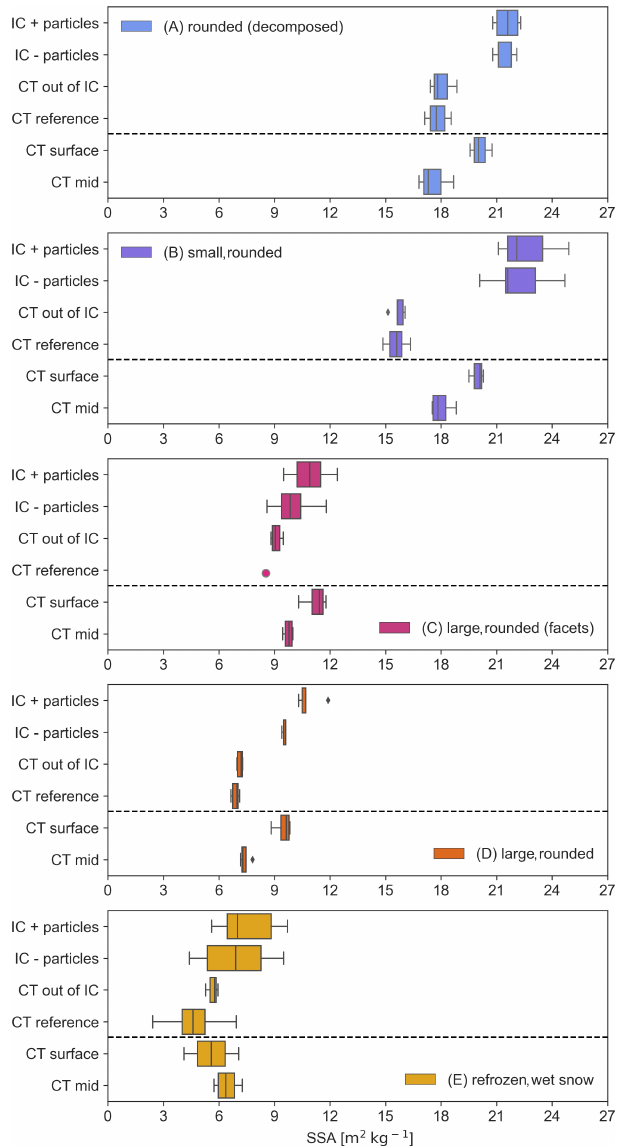
Figure 7. All SSA measurements classified into snow types and subdivided into sampling steps; SSA values ranged between 5 and 25m 2 kg − 1 . “IC + particles” is the default sampling process (Gallet et al., 2009). Results for the micro-CT sampling kit are separated by the dotted grey line in each plot; SSA values ranged between 5 and 22m 2 kg − 1 . The results can be found in Table 1.